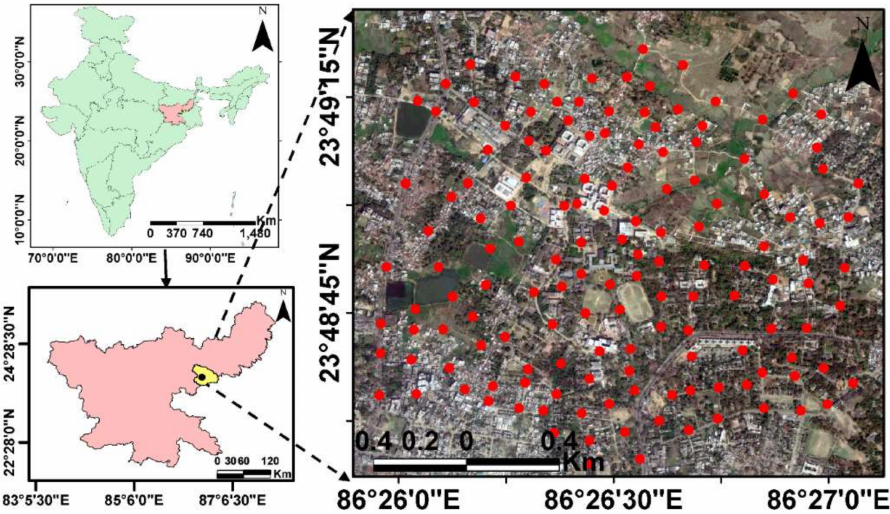
Figure 1. The distribution of 145 number of ground control points (GCPs) across the study region